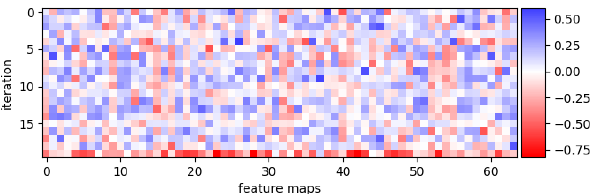
Figure 2. Visualization of the mean activation of each convolutional filter at every